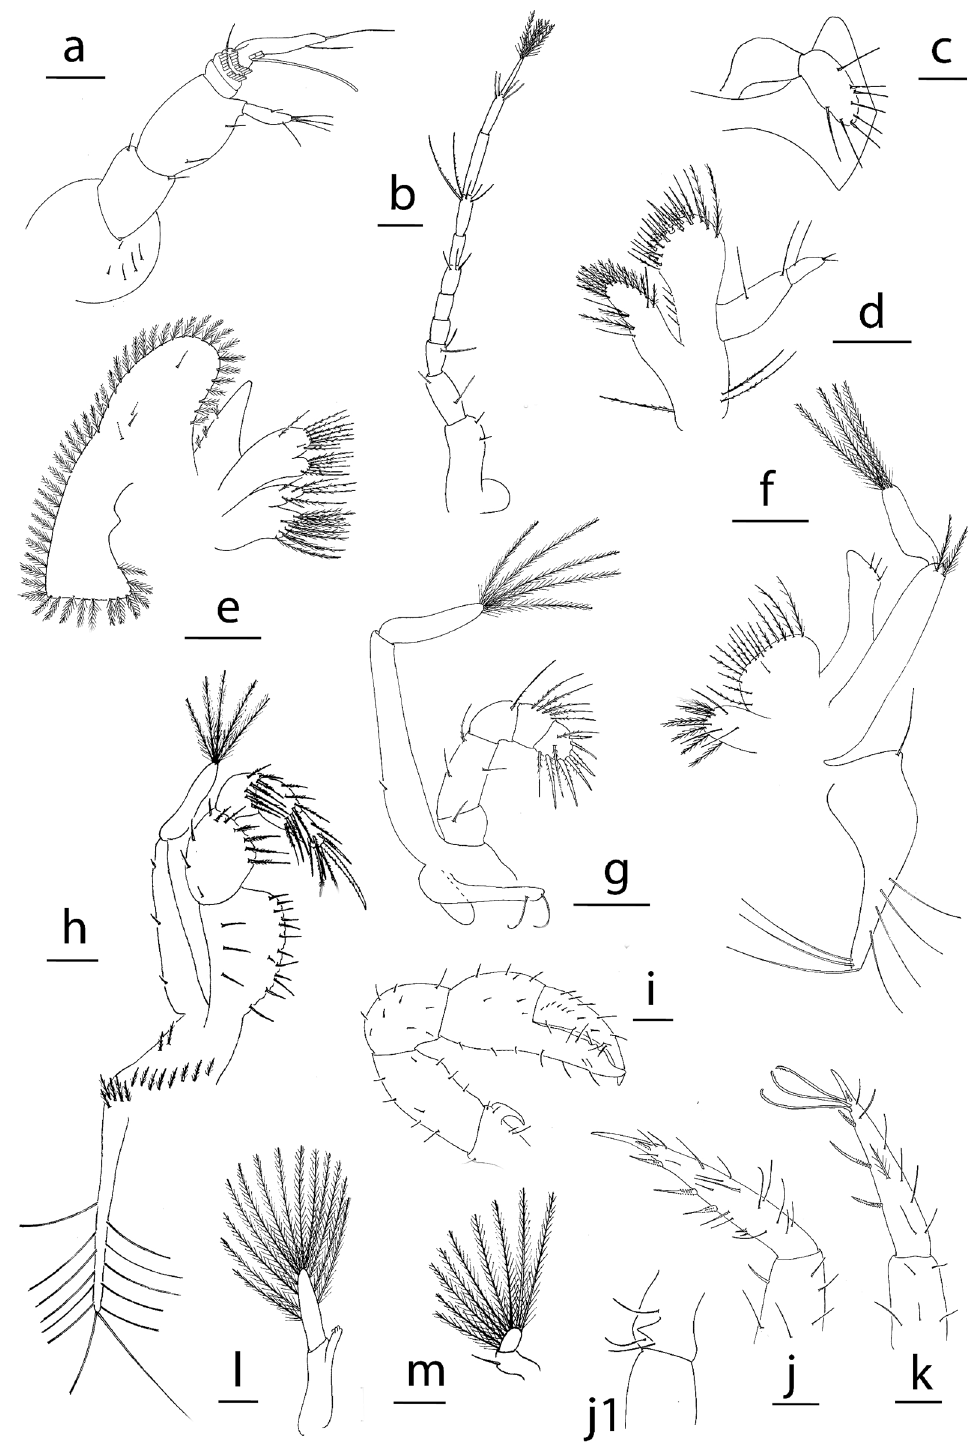
Figure 6. Appendages of Neoliomera cerasinus : ( a ) antennule; ( b ) antenna; ( c ) mandible; ( d ) maxillule; ( e ) maxilla; ( f ) first maxilliped; ( g ) second maxilliped; ( h ) third maxilliped; ( i ) cheliped; ( j ) dactylus of second pereiopod; ( j,1 ) detail of dactylus of second pereiopod; ( k ), dactylus of fifth pereiopod; ( l ) second pleopod; ( m ) uropod. Scale bars: 0.1